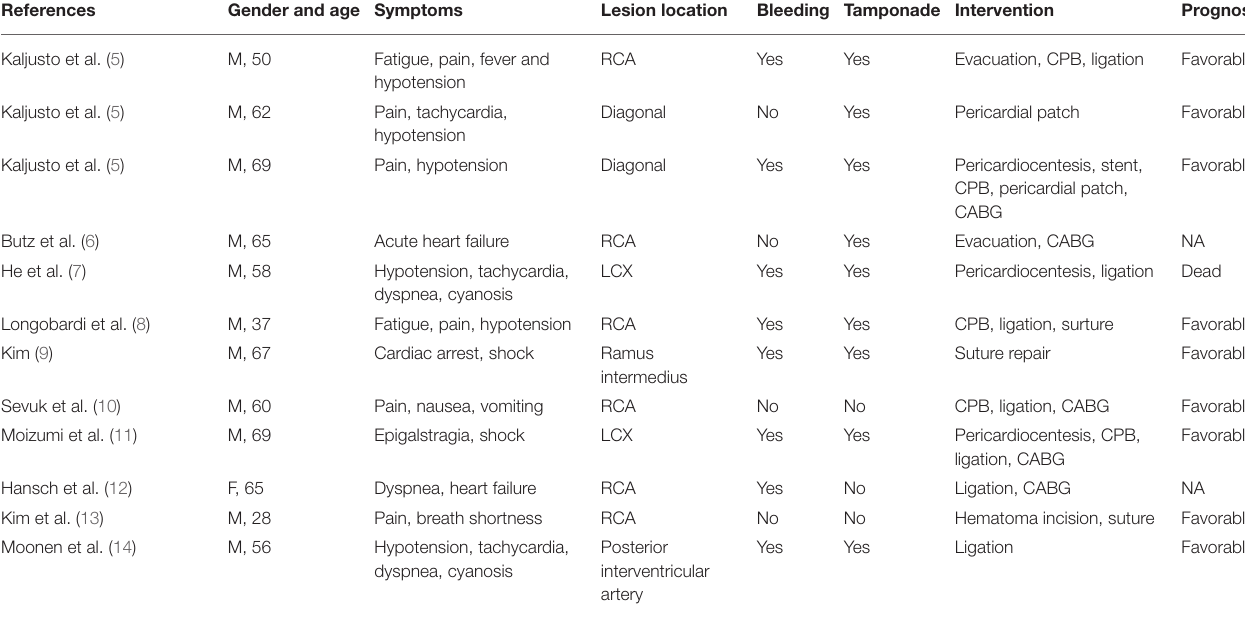
TABLE 1 | Related cases reported as spontaneous coronary artery rupture in the